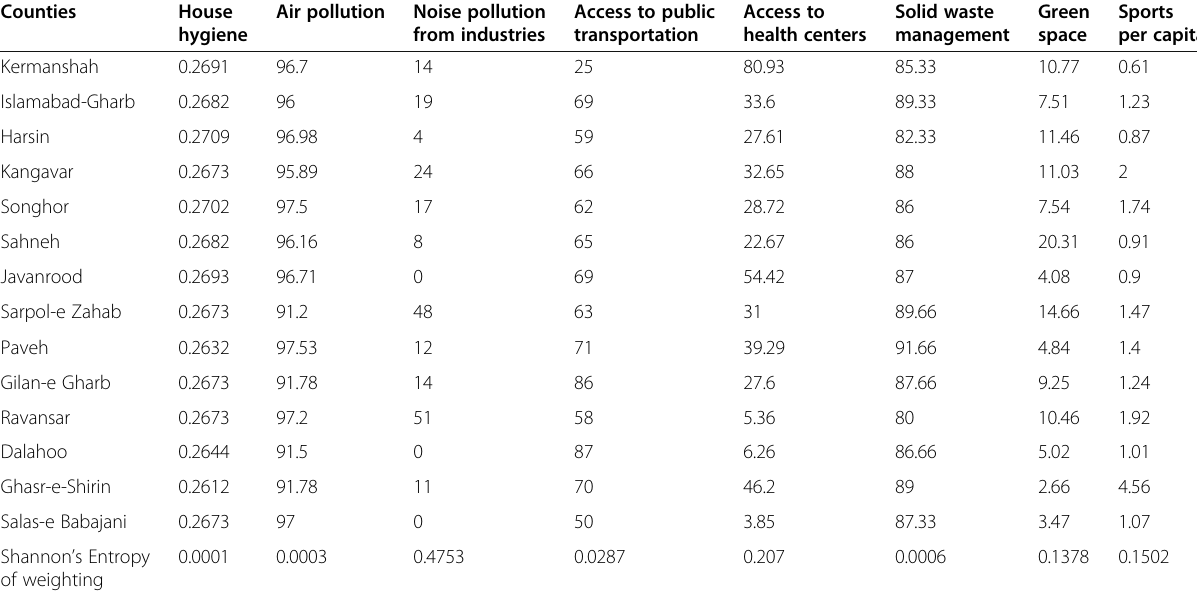
Table 3 Standardized matrix of